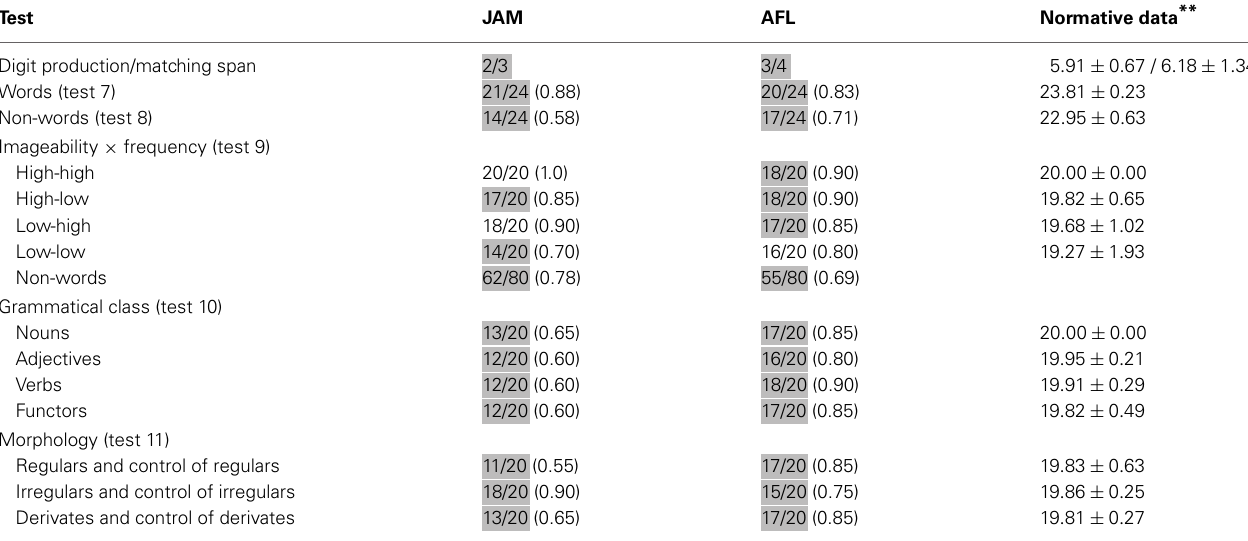
Table 2 | Auditory processing: repetition of digits, single words, and